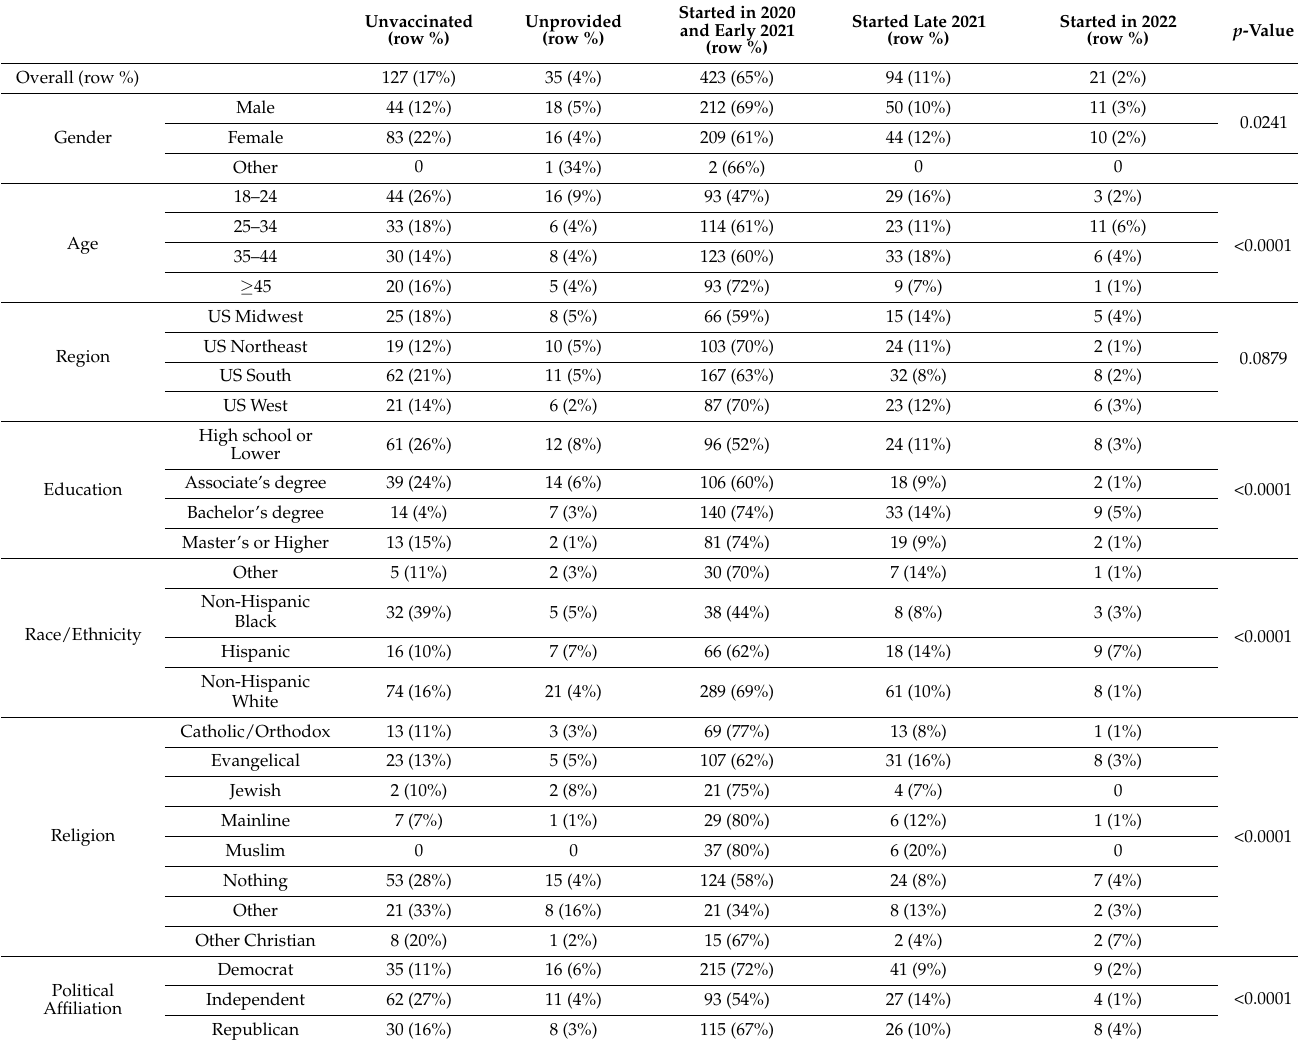
Table 2. Vaccination timing, and its distribution by demographic characteristics, race/ethnicity, religion, and political affiliation, United States, August